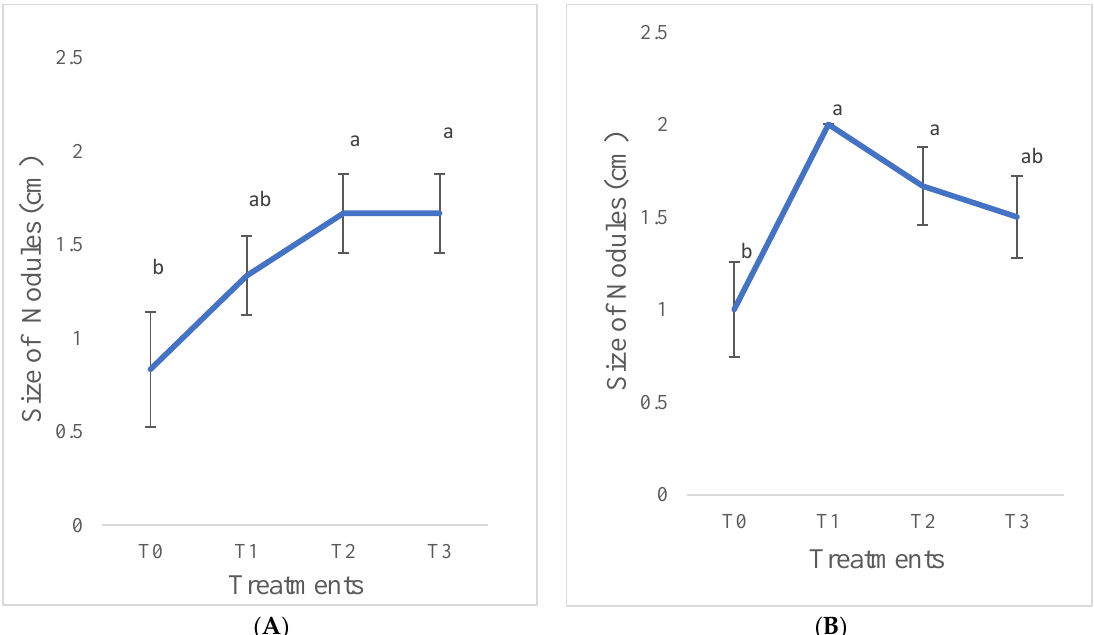
Figure 4. Lucerne size of nodules under inoculation with liquid formulation (T0, T1, T2, and T3) of Sinorhizobium meliloti in climatic zone ( A ) = Bronkhorspruit/Gauteng and ( B ) = Hartbeesfoein/Northwest Province). Bars sharing a letter are not significantly different (Lsd Zone A) = 0.742 and (Lsd Zone B) =0.645. Data are means ± standard errors.